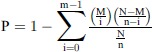
The GO enrichment analysis of predicted targets of differentially expressed miRNAs with P< 0.05.Note: A: Biological process, B: Molecular function, C: Cellular component. The GO terms were sorted by the enrichment p-value calculated by the calculating formula:
P=1−∑i =0m−1(Mi)(N−Mn−i)Nn
The N represented the number of GO annotated genes in genome, n represented the number of differentially expressed genes in N. M represented the number of particular GO annotated genes in genome, m represented the number of particular GO annotated genes expressed differentially in M.